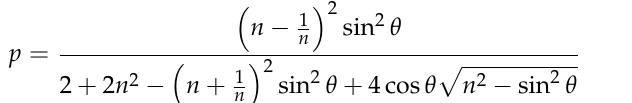
Figure 1. Overall schematic of the 3D face reconstruction method.